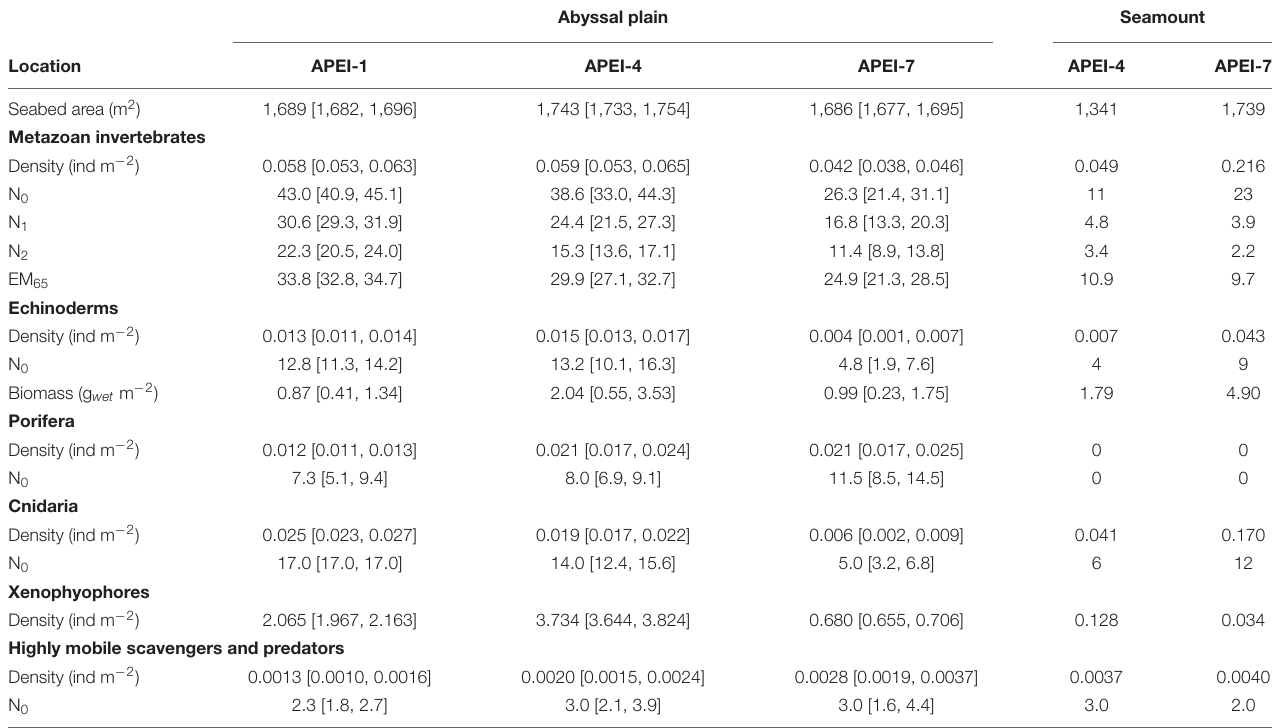
TABLE 3 | Megafaunal community metrics by APEI and habitat type expressed as means [95% confidence interval of the mean] determined in photographic sample units: density, univariate diversity metrics (Hill numbers N 0 [number of morphotypes], N 1 [Shannon index] and N 2 [Simpson’s index]; expected number of morphotypes rarefied to 65 specimens, EM 65 ), fresh wet weight biomass of